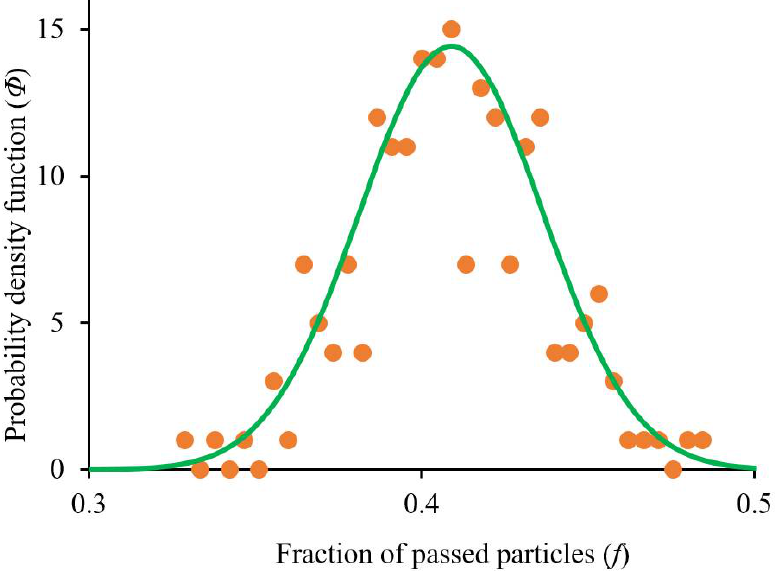
Figure 5. Probability density function for helium atoms. Orange color corresponds to calculations (additive approach). Green color corresponds to the normal distribution (15).